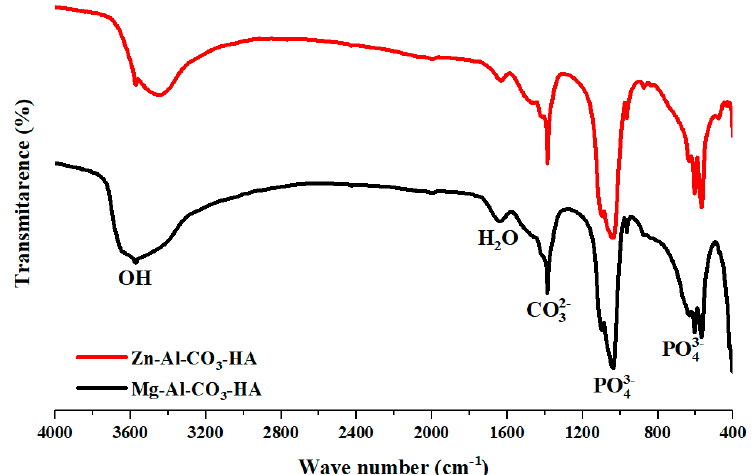
Figure 1. FTIR spectra of Zn-Al-CO 3 -hydroxyapatite (HA) and Mg-Al-CO 3 -HA layered double hydroxide (LDHs).